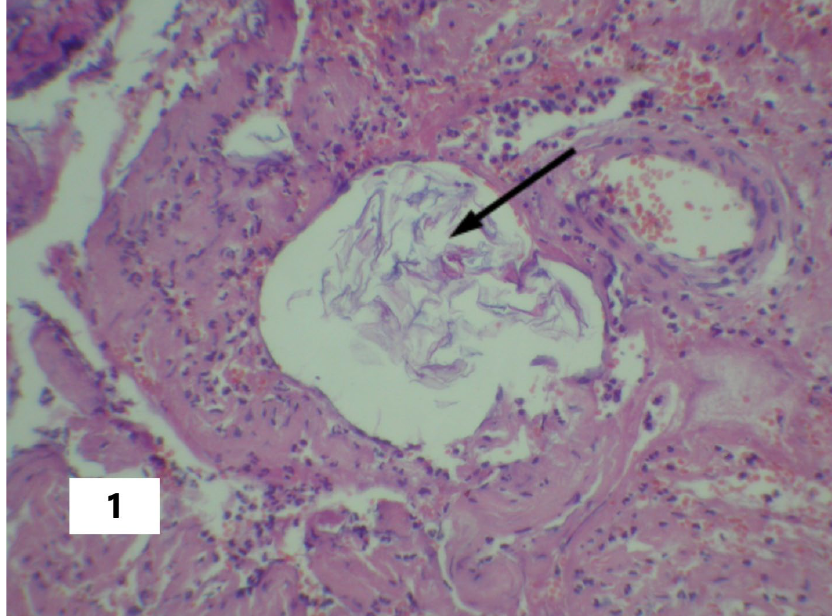
Figure 1. Fetal squamous cells in the maternal lacunar transformed veins of a cervix. The arrow indicates fetal squamous cells in the vessel lumen (Hematoxylin and Eosin stain, ×100 magnification). Pathophysiology 2023 , 30 , FOR PEER REVIEW